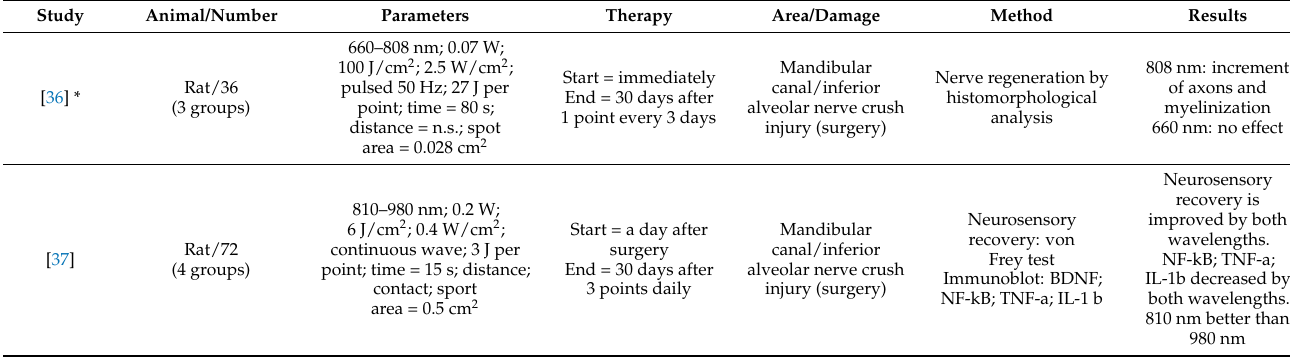
Figure 1. From a cellular point of view, photobiomodulation event is the results of cellular interac- tion sequences that from the primary target, represented by photoacceptor, move through second messengers and conclude with a modulation of the tissue’s homeostasis. The primary target can be identified in the cytochromes of the mitochondrial respiratory chain ( a ), the nitrosothiol compounds ( b ), the lipids ( c ) and the bounded water ( d ), which after the interaction with red and, particularly, infrared light, modify their energetic and vibrational state, supporting the release of ATP and ROS ( a ) and nitric oxide ( b ), as well as calcium, through the opening of voltage-dependent receptors and release from intra-organellar-sequestered reserves ( c , d ). Red arrows represent the laser light. Image created with BioRender.com. Table 1. Included studies. Preclinical in vivo studies on photobiomodulation and trigeminal branches nerves recovery, selected after inclusion and exclusion criteria and ARRIVE guideline screening. The table shows the schematic design of the experimental set-up on animals and the